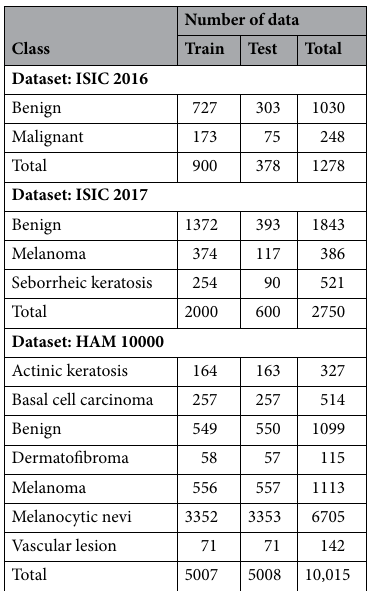
Table 7. Distribution of data in dermatoscopic